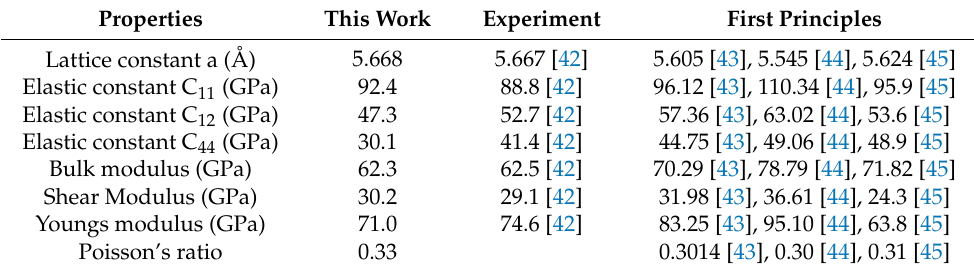
Table 2. Properties of ZnSe calculated by the selected interatomic potential in this work, compared with the reported data from experiments and first principles